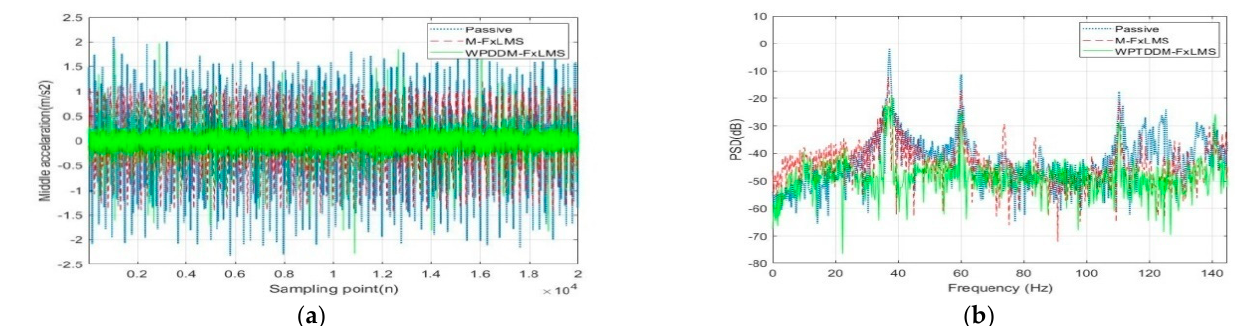
Figure 17. ( a ) The time domain acceleration signal in measuring point 2#; ( b ) the acceleration signal spectrum in meas- uring point 2#.